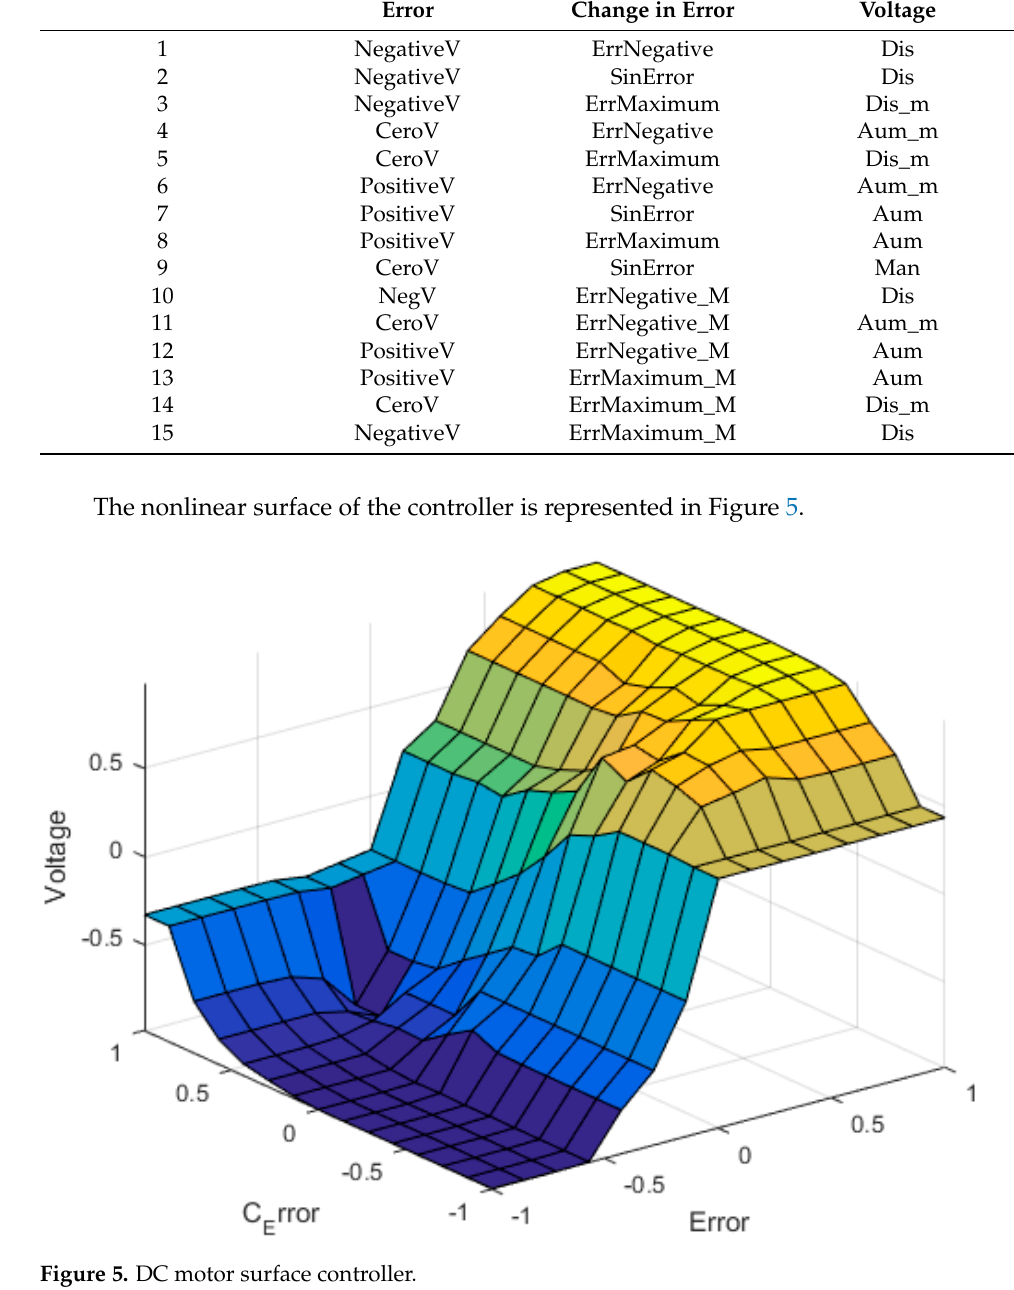
Figure 6. IT-T2 with uncertain parameter 𝑎 .